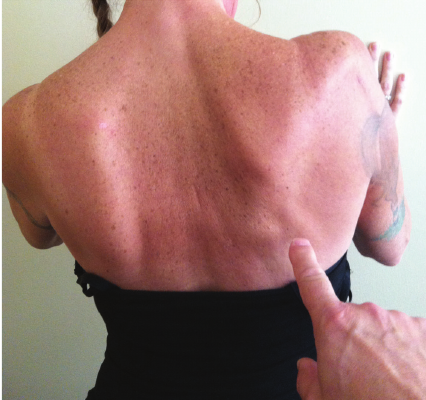
Figure 4: Photo taken 18 months after the index TSA shows the patient’s back while she presses her hands against the wall in front of her. Although scapular winging is still obvious, there is increased mass of the trapezius when compared to the image taken 14 months prior (Figure 1). Although periscapular muscle tone had improved, shoulder function was not significantly